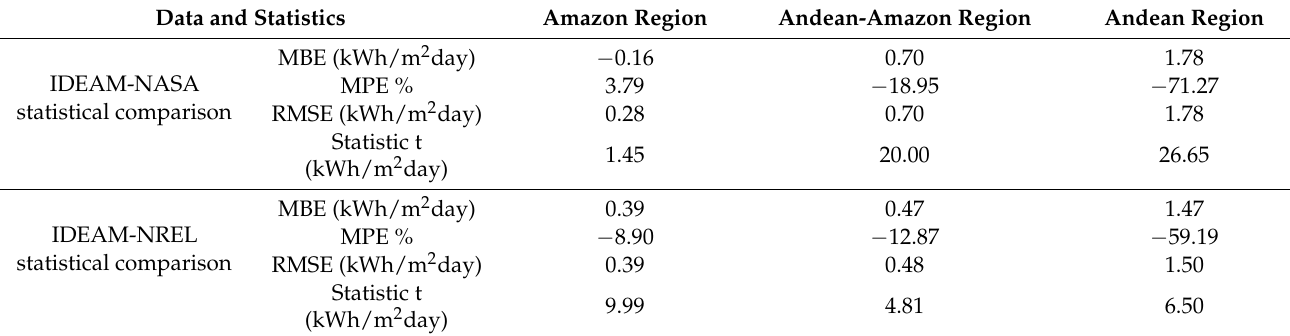
Table 5. Comparison of IDEAM-NASA and IDEAM-NREL irradiance values G da by region. Data and Statistics Amazon Region Andean-Amazon Region Andean